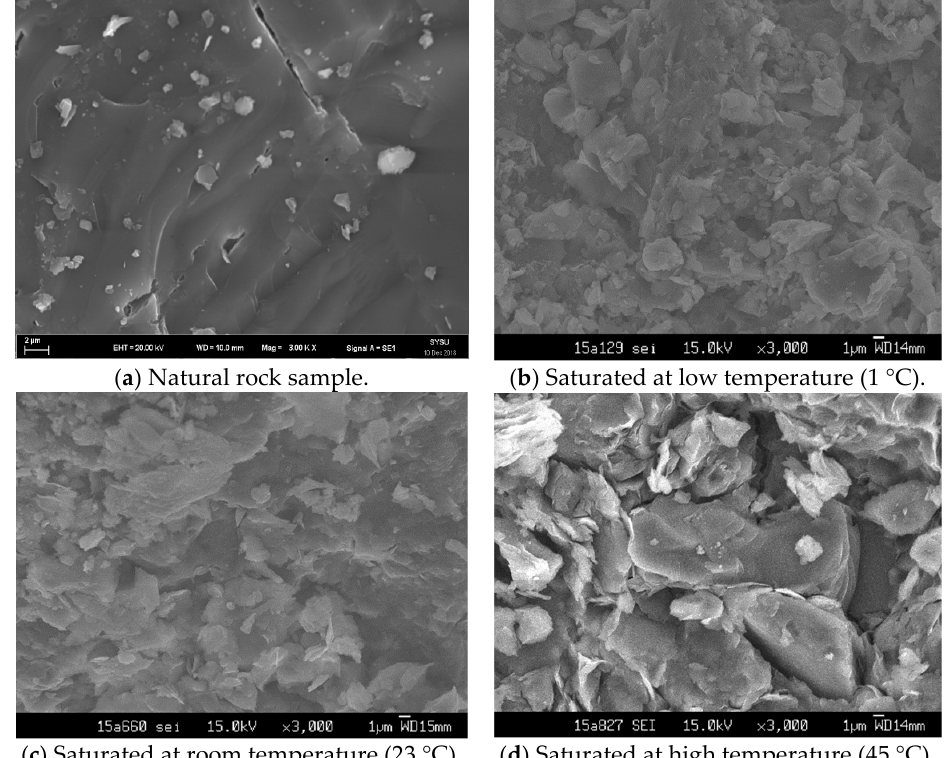
Figure 10. Change diagram of the micro-structures of the rock samples at different temperatures (3000×).